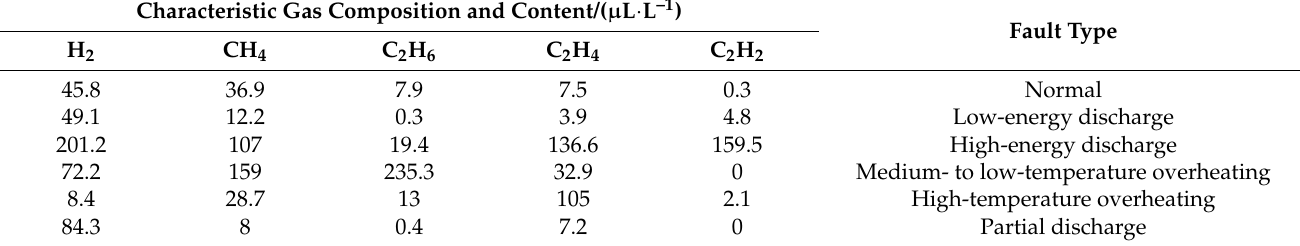
Table 4. Transformer Original Fault